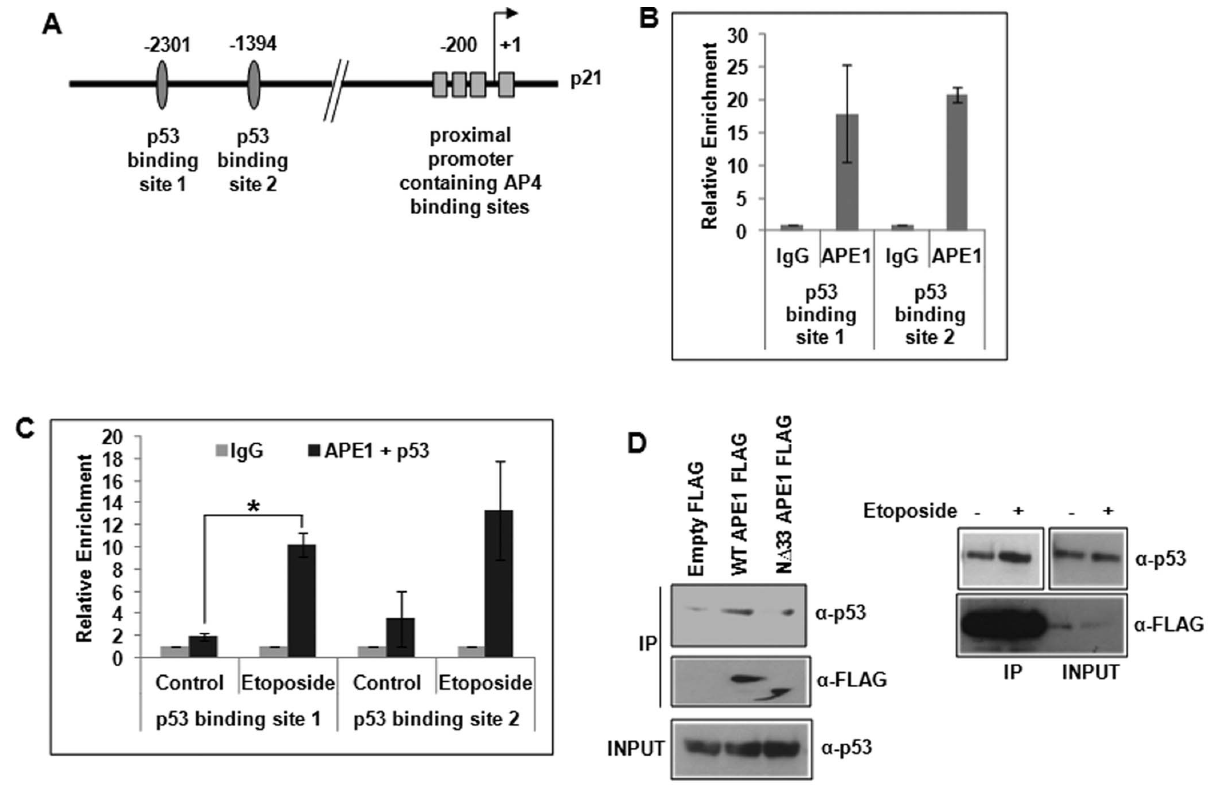
Figure 1. Association of p53 and APE1 on p53-binding sites in p21 promoter. ( A ) p21 promoter structure showing p53 and AP4 binding sites. ( B ) ChIP Real Time PCR analysis showing relative enrichment (2 2 D CT ) of APE1-immunoprecipitated DNA over that from control IgG in p21 promoter regions containing p53 binding sites 1 & 2 in HCT116 WT cells. ( C ) Re-ChIP analysis (first IP with a -APE1 and the second IP with a -p53 antibody) showing simultaneous recruitment of APE1 and p53 in control vs. etoposide treated cells; *: p value , 0.05 (n=2) calculated based on APE1/p53 enriched DNA from control vs. etoposide treated cells. ( D ) Western analysis of FLAG immunoprecipitate (IP) to detect APE1-associated p53 and FLAG (APE1) from empty vector vs. FLAG-tagged WT APE1 or FLAG-tagged N D 33 APE1 transfected HCT116 WT cells (left panel) and from control vs. etoposide-treated WT APE1-FLAG transfected cells (right panel).